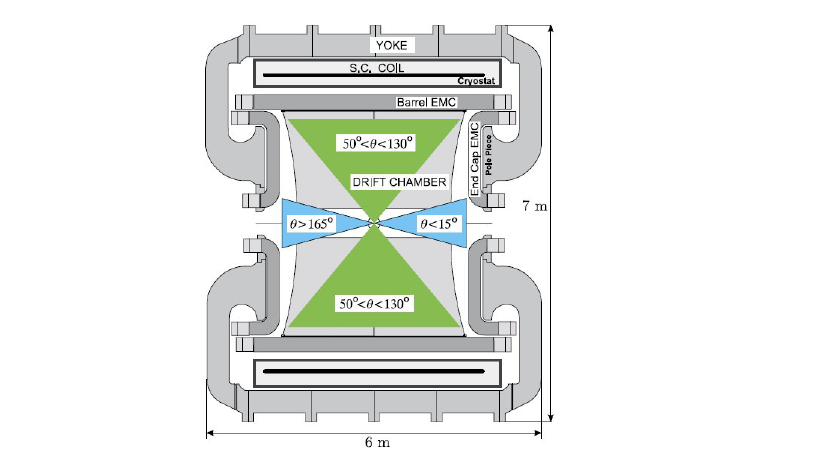
Figure 1. Detector section with the acceptance region for the charged tracks (wide cones) and for the photon (narrow